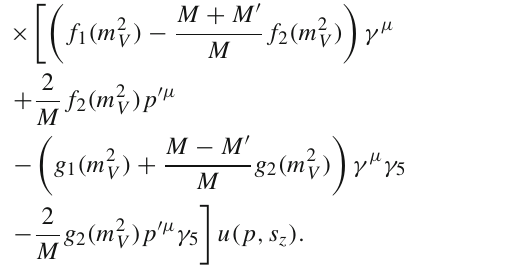
between (cid:2) 0 c /(cid:2) (cid:5) 0 c and π + /ρ + , and diagrams d, e and f by the rescatter- ing between (cid:6) + c /(cid:5) + c and ¯ K 0 / ¯ K ∗ 0 . Each thick line in diagrams a and d denotes a resonant